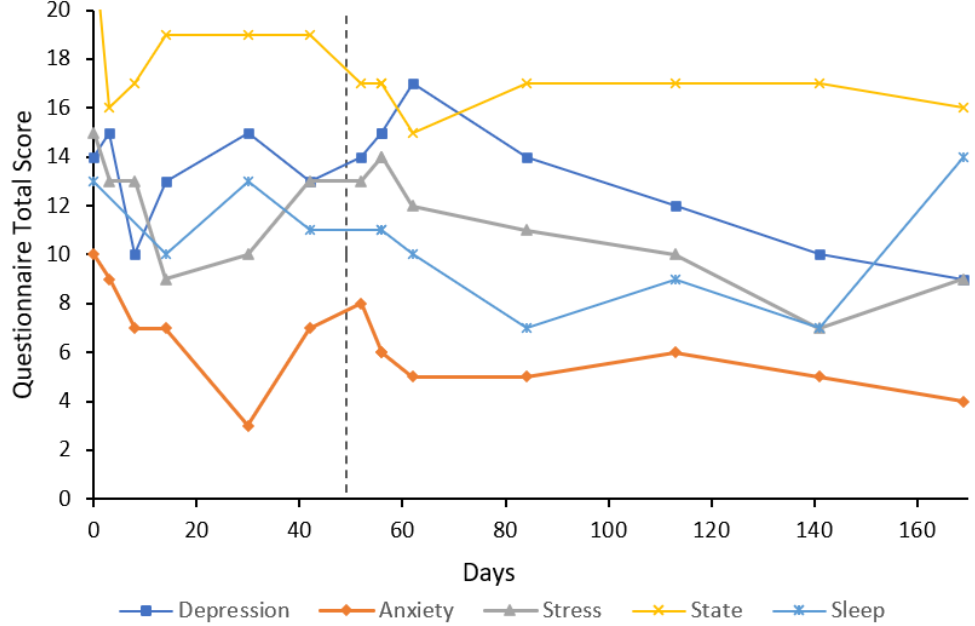
Figure 4. Line graph showing Case 4 results from the DASS-21 (depression, anxiety, and stress subscales), SSAI-6, and JSS at each follow-up. The participant was treated with an eight-day flumazenil infusion and re-treated on day 49 with a four-day flumazenil infusion (denoted by a dashed line). Case 5 was a 20-year-old female, undergraduate university student, with an eight-year history of GAD with treatment resistance and comorbid social anxiety disorder. The participant had previously taken paroxetine and fluoxetine with no effect on anxiety symptoms. Poor sleep quality was reported, waking multiple times a night with nightmares about a previous abusive relationship and bullying. U&E, LFT, and TFT were unremarkable at baseline. Baseline anxiety and stress subscale scores were both extremely severe at 15 and 19, respectively (Figure 5). Treatment response was achieved by day 28 on both subscales; however, remission was never achieved in this participant. Increases in anxiety measures at day 88 were associated with significant stress due to an accident involving a close family member. Re-treatment was offered prior to this at approximately 90 days; however, given the circumstances and a needle phobia, the participant declined. The participant was re-treated with an eight-day flumazenil infusion at day 182 due to worsening anxiety symptoms, which the participant reported had improved since the first infusion. Following this, treatment response was achieved at day 217, which was 35 days after the second eight-day infusion began. State anxiety fluctuated above and below baseline (18) and ranged from 11 – 20. The participant reported some improvements in sleep occurring shortly after the flumazenil infusions; sleep scores ranged from 13 – 19 with a baseline score of 17. Trait anxiety at baseline was 57 and was essentially unchanged at day 88 at 56. By day 175, trait anxiety had increased to 66; however, 35 days after re-treatment, trait anxiety had decreased to 48. No further blood tests were completed due to the needle phobia.